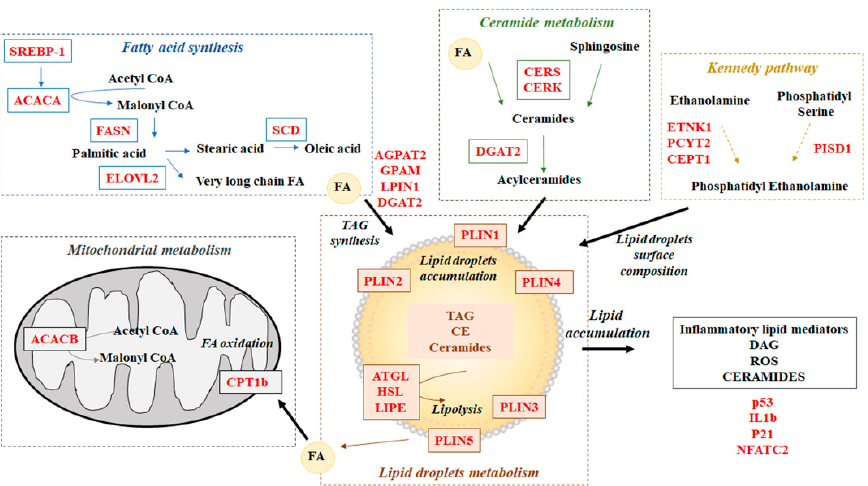
Figure 1. Metabolic pathway of genes considered in the study. FA = fatty acids; TAG = triacylglycerol; CE = Esterified Cholesterol; DAG = Diacylglycerol; ROS = Reactive Oxygen Species.